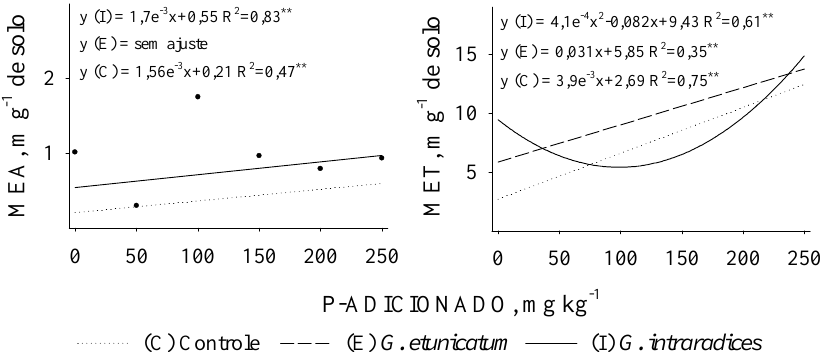
Figura 3. Comprimento de micélio extra-radicular ativo (MEA) e total (MET) de G. etunicatum , G. intraradices ou controle sem FMA, considerando as doses de P. * e ** significativos a 5 e 1%,